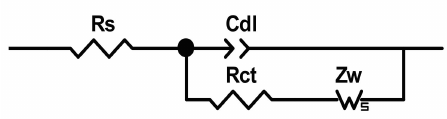
Figure 1. Equivalent circuit employed by Randles to model an unpainted metal [25].